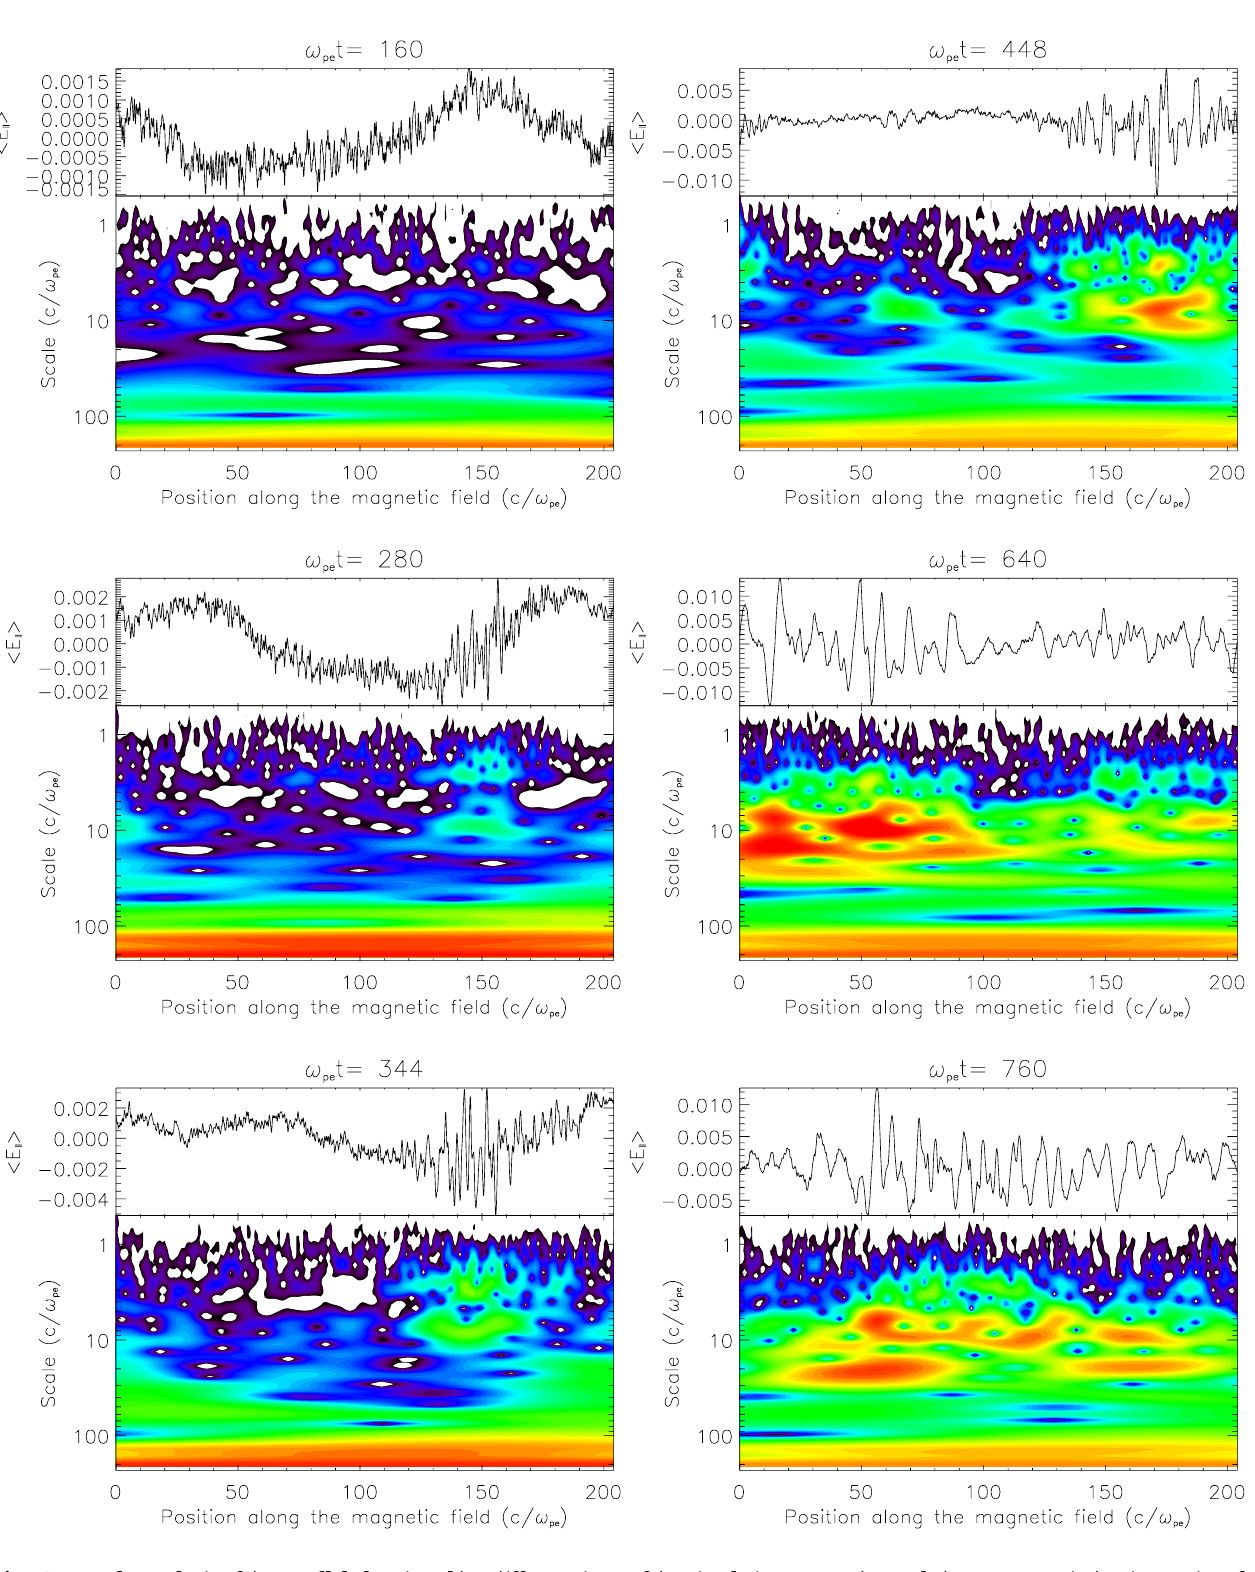
Fig. 10. Wavelet analysis of the parallel electric field at different times of the simulation. For each panel, the upper part is the time series of the parallel electric field averaged in the (negative) gradient region; on the bottom part, the wavelet power spectrum is plotted as a function of the position along the magnetic field and the scales of field structures. The colour code, in logarithmic scale, is common to all